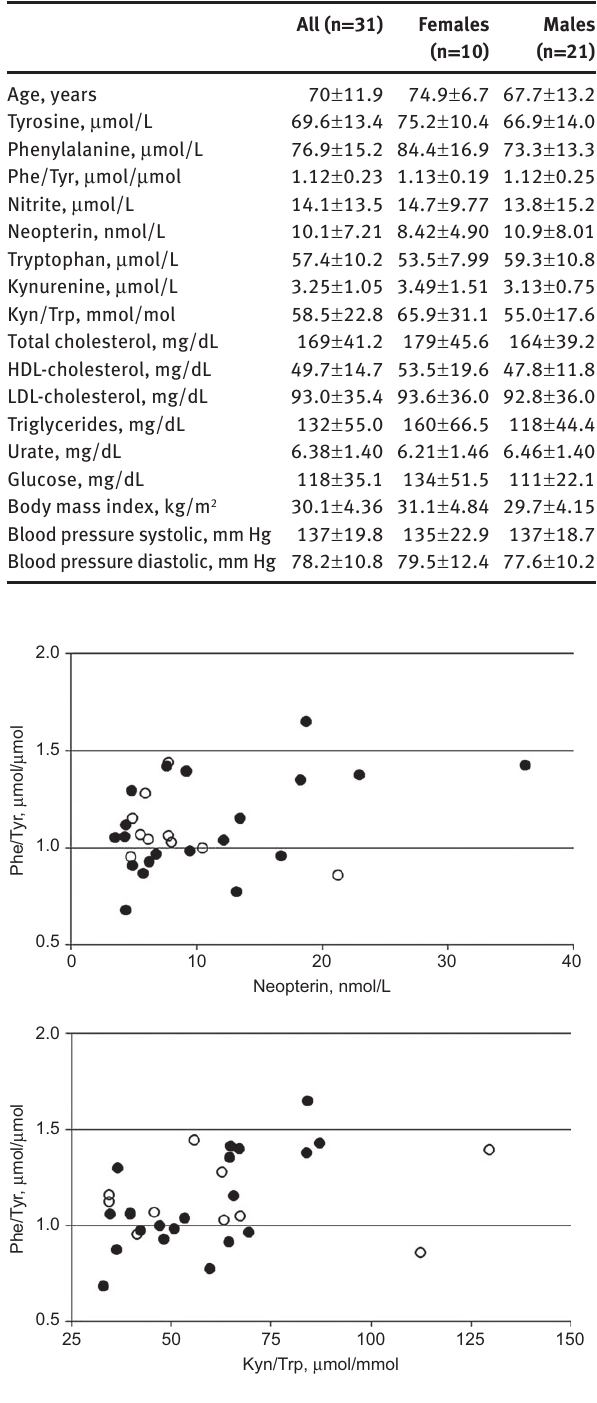
Figure 1 Associations of serum phenylalanine-to-tyrosine ratios (Phe/Tyr) with neopterin concentrations (r = 0.354, p < 0.05; upper graph) and with kynurenine-to-tryptophan ratios (Kyn/Trp) (r = 0.396, p < 0.05; lower graph) in 31 patients with coronary artery disease (open circles, 10 females; filled circles, 21